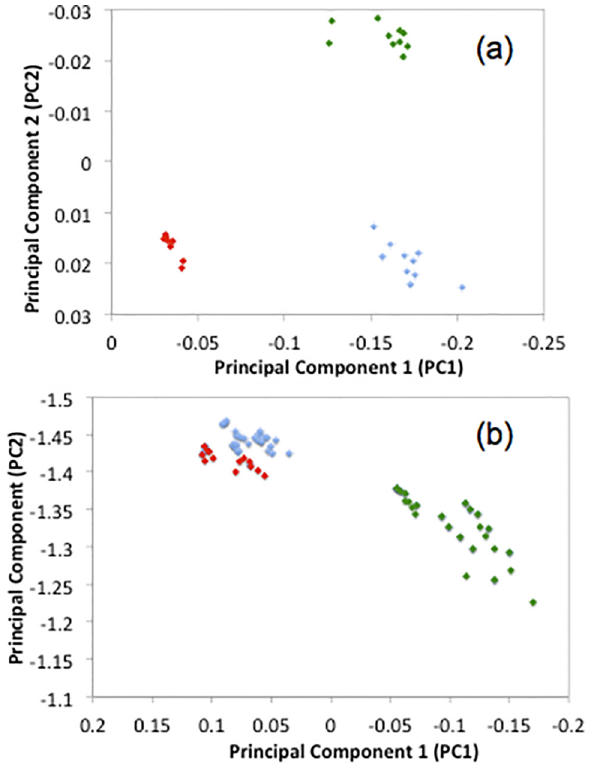
Fig 3. Principal component analysis of (a) WMRS study of paper microfluidics device (green), as well as paper + paracetamol (blue) and paper + Ibuprofen (red). (b) Standard Raman study of paper microfluidics device, as well as paper + paracetamol and paper + Ibuprofen.